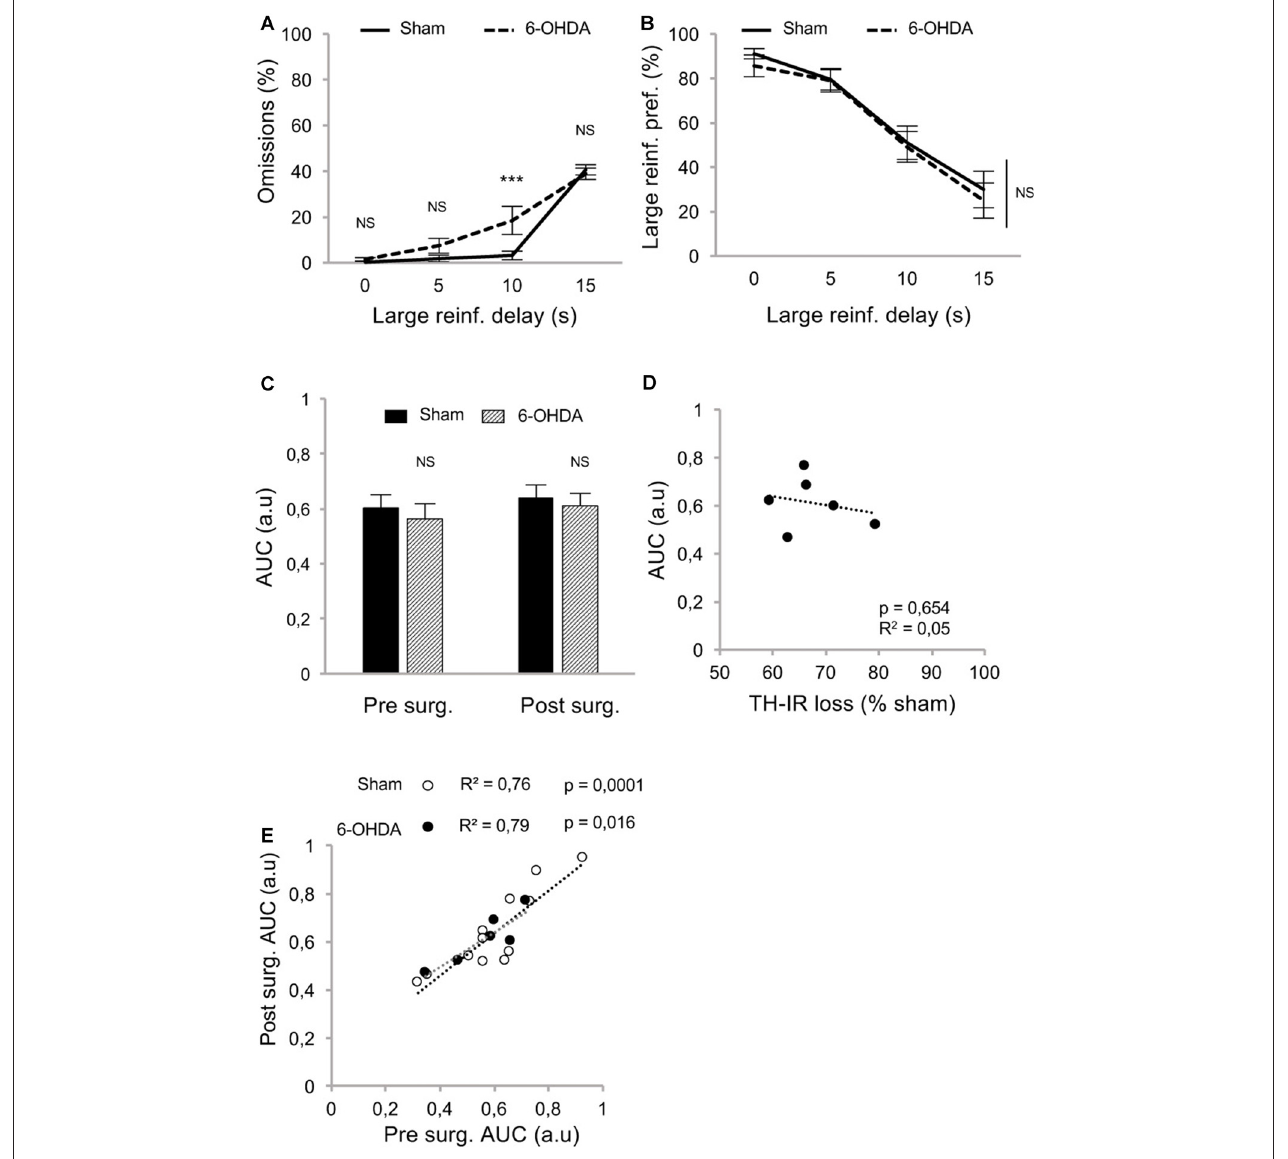
FIGURE 4 | Partial nigrostriatal denervation does not affect impulsivity in a between-session DDT (between-DDT). (A) Percentage of omissions in sham and 6-OHDA lesioned rats during between-DDT. Data are represented as mean of omissions ± SEM in function of delay (averaged from each delay from the last three sessions). (B) Similar discounting pattern between sham and 6-OHDA lesioned rats, expressed as percentage of preference for the large reinforcer over the smaller one, in function of delay. Data are represented as mean ± SEM and were averaged from the last three sessions for each delay. (C) Similar discounting AUC, between sham and 6-OHDA lesioned rats, pre- and post-surgery period. The AUC is extrapolated from AUC and expressed as mean value ± SEM for each group. (D) No correlation between the post-surgical AUC and the degree of dorsal striatum TH-IR loss. Dots represent individual values for the AUC and dorsal striatum TH-IR loss expressed as percentage of sham mean value. (E) Positive and significant correlation between pre and post-surgery of individual AUC values for sham and 6-OHDA lesioned rats ( p s < 0.05). NS, non-significant, ∗∗∗ p < 0.001; Sham ( n = 12) vs. 6-OHDA ( n = 6), reinf, reinforcer; AUC, area under the discounting curve; a.u, arbitrary